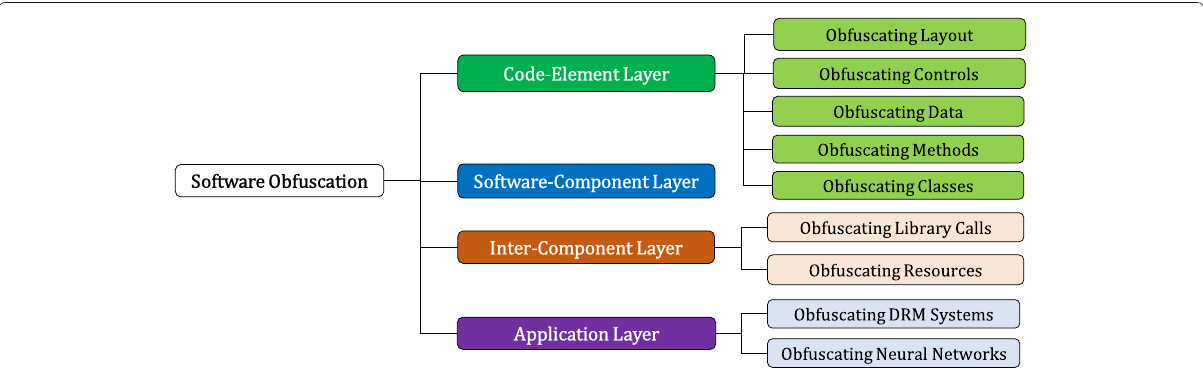
Fig. 3 The taxonomy of software obfuscation techniques for layered security